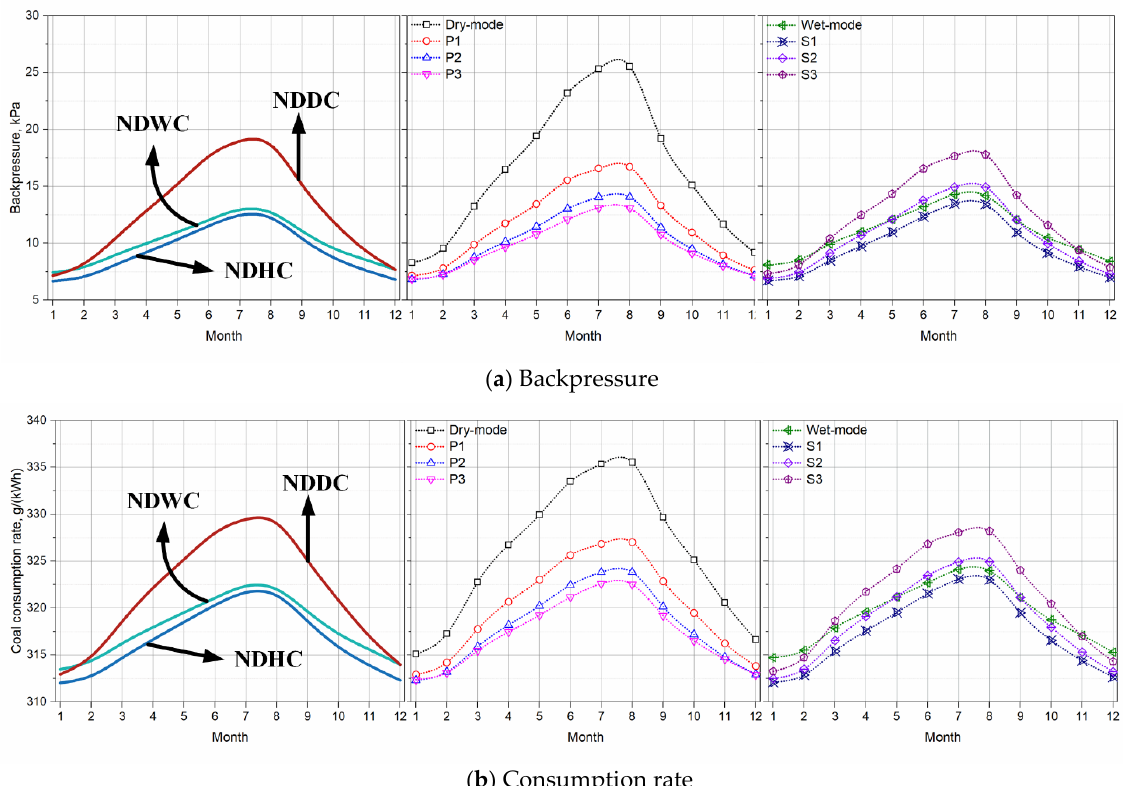
Figure 11. Annual variations of backpressure and coal consumption rate of different cooling systems.